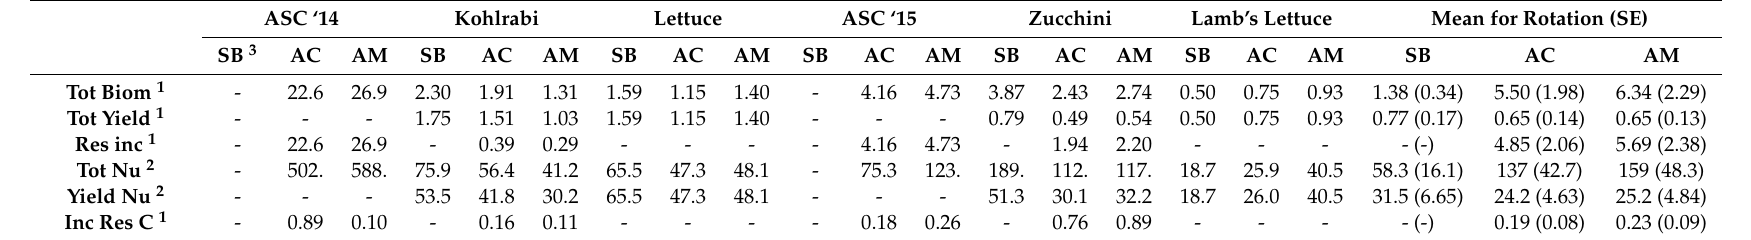
Table 6. Means of plant parameters for the three organic systems during the two-year rotation